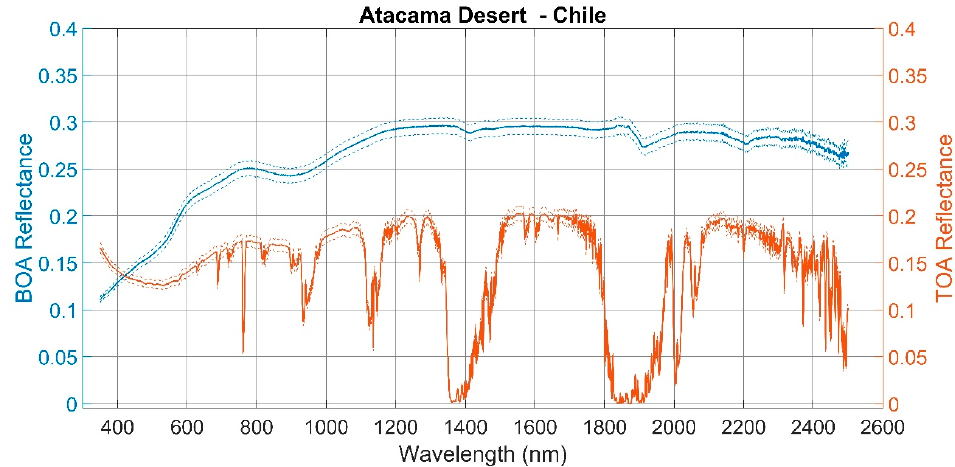
Figure 3. In the y -axis left and right side of the graph is presented, respectively, the BOA and TOA reflectance of Atacama Desert measured in situ in August 2014. reflectance of Atacama Desert measured in situ in August